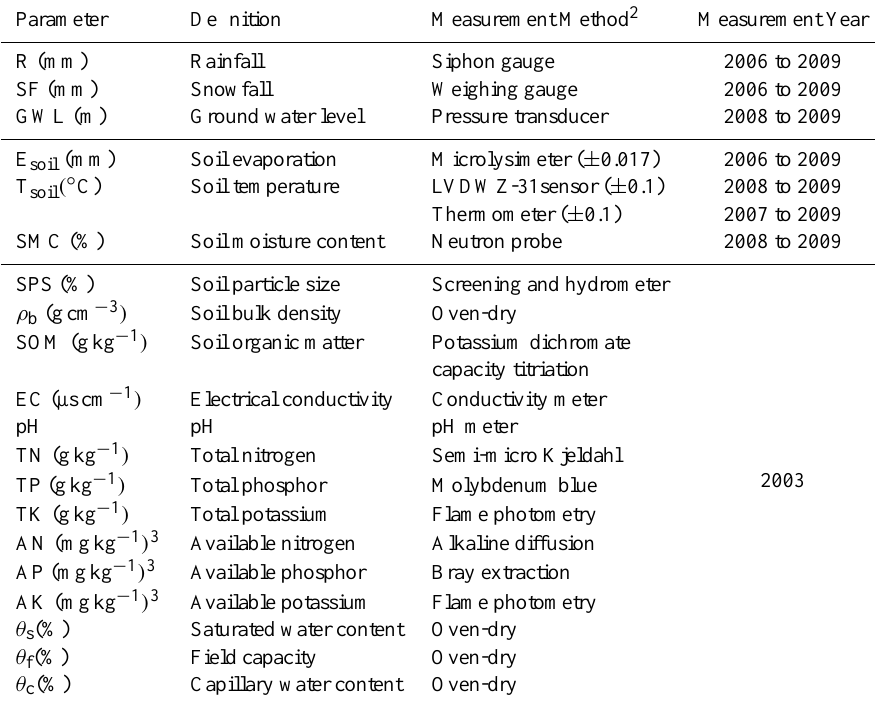
Table 1. The manually (i.e., nonautomatically) measured parameters.